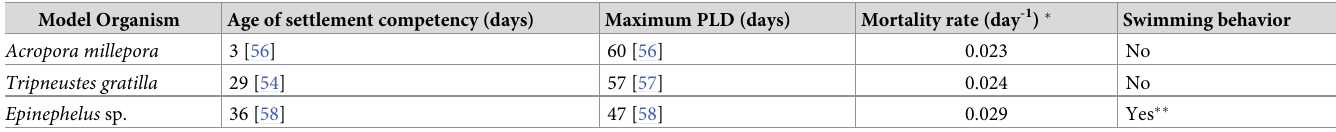
Table 1. Early life history characteristics of model organisms. Empirical values were based on the representative organisms. Model